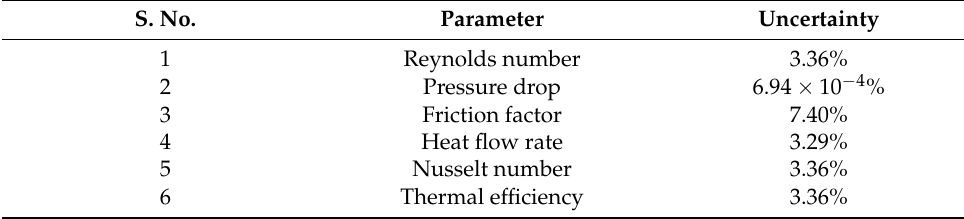
Table 9. Different parameters